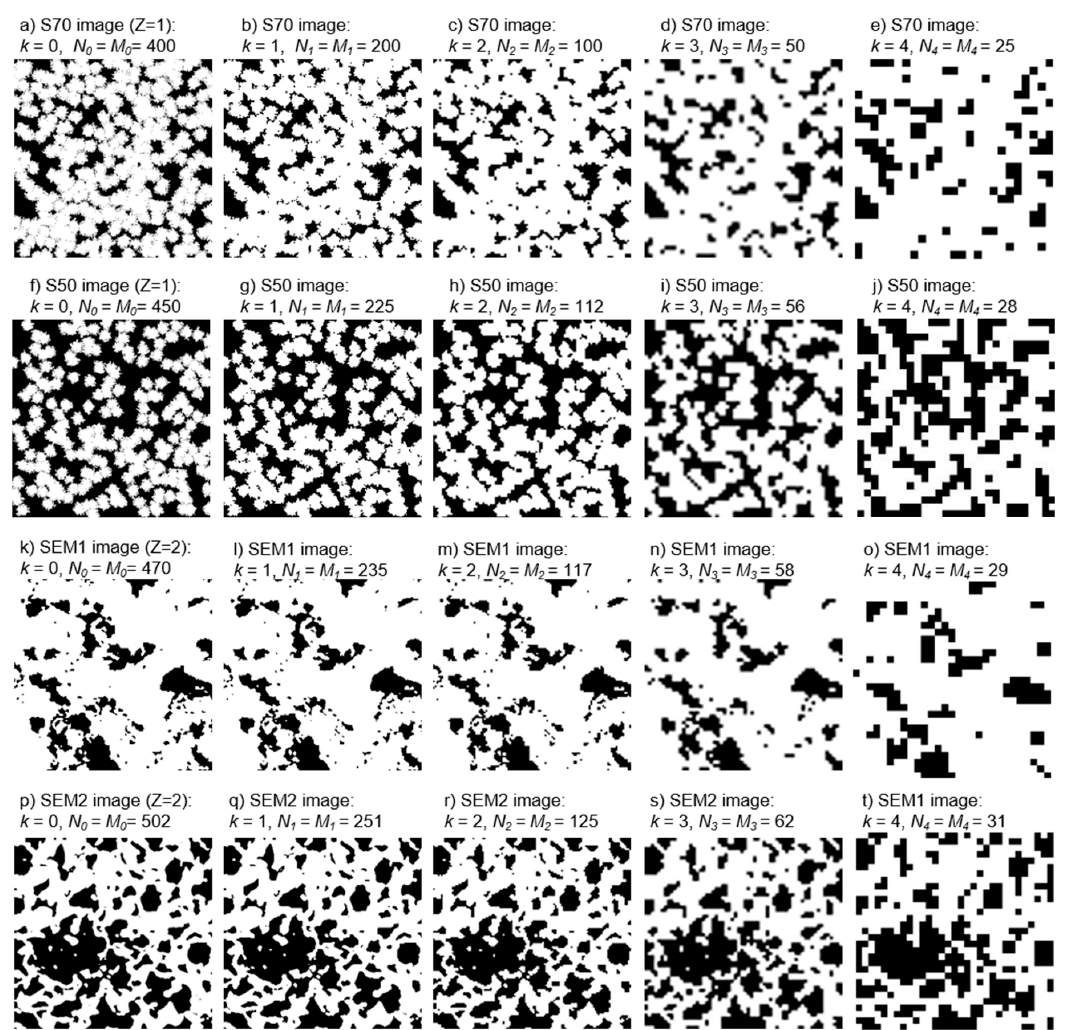
Figure 2. Decimation process of SEM and synthesized images for different k respect to full resolution image for each material.